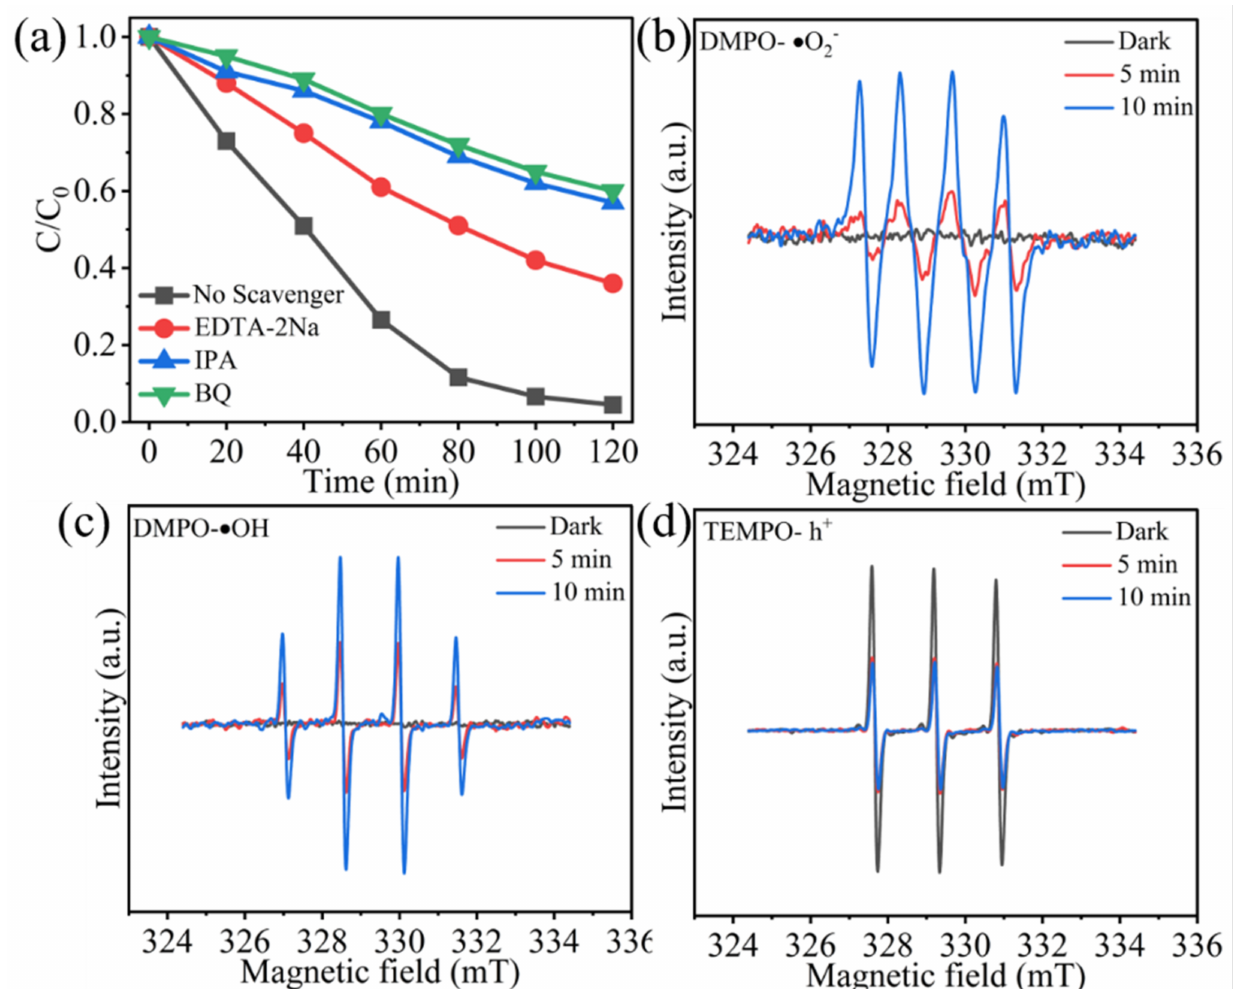
Figure 14. ( a ) Trapping experiment of active species during the PEC degradation of TC over MBI2 sample; ( b ) ESR spectra of TEMPO—h + adduct; ( c ) DMPO— • O 2 − adduct; and ( d ) DMPO— • OH adduct over MBI2